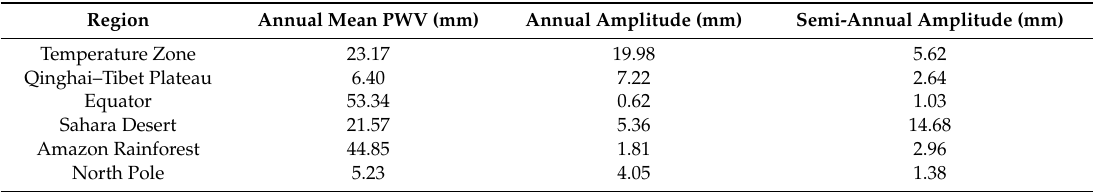
Table 2. The mean value, annual amplitude, and semi-annual amplitude of precipitable water vapor (PWV) in the six